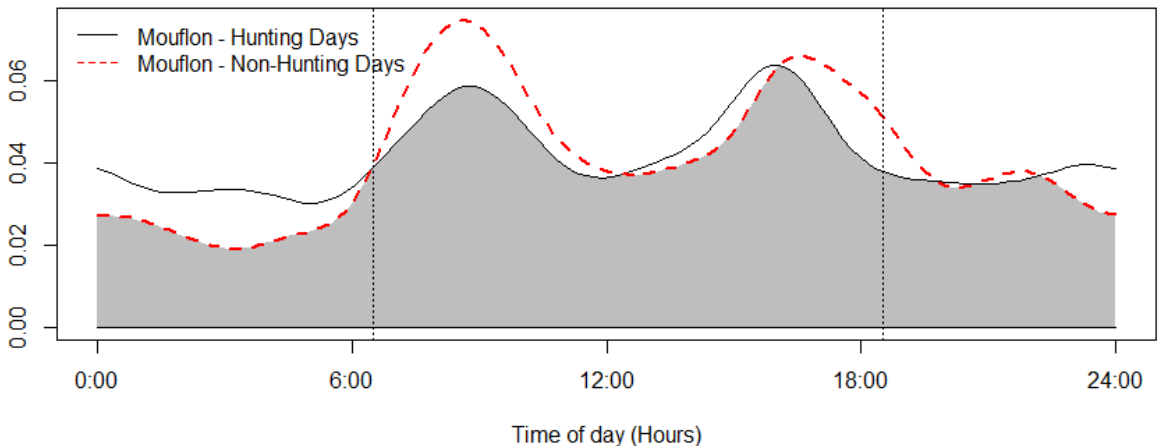
Figure 4. Mouflon activity overlap of days with and without hunting (coefficient of overlap Δ = 0.91). Sunrise and sunset are marked at their average time for the study period (gray zone shows the overlap area).